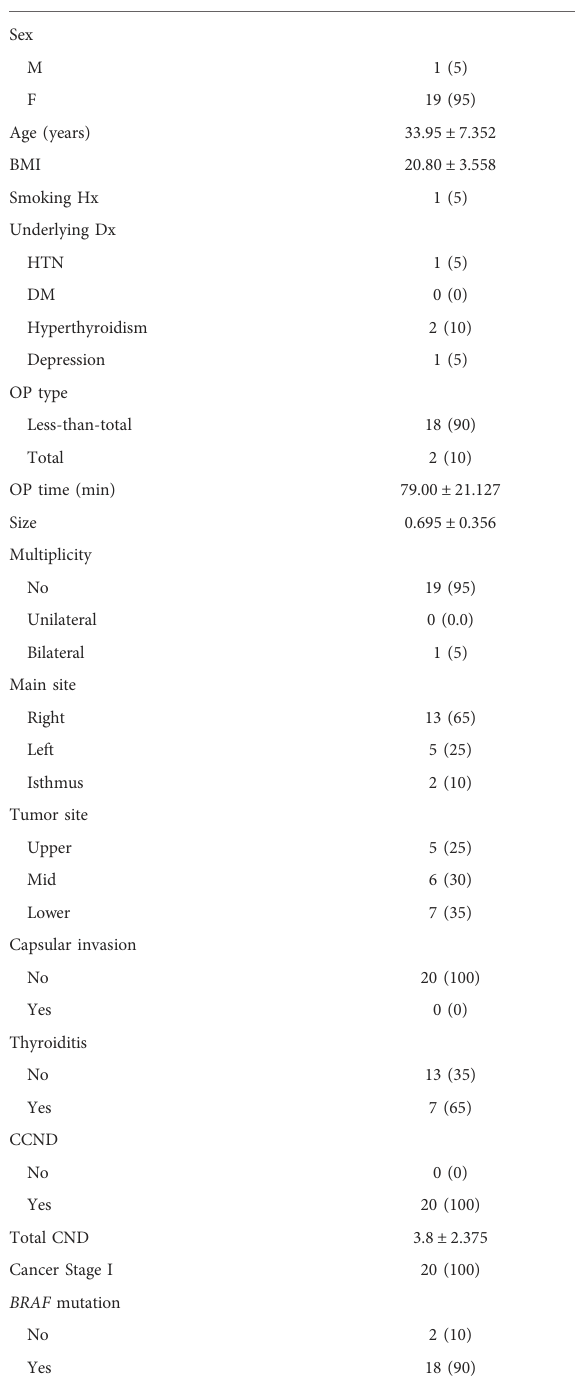
TABLE 1 Patient